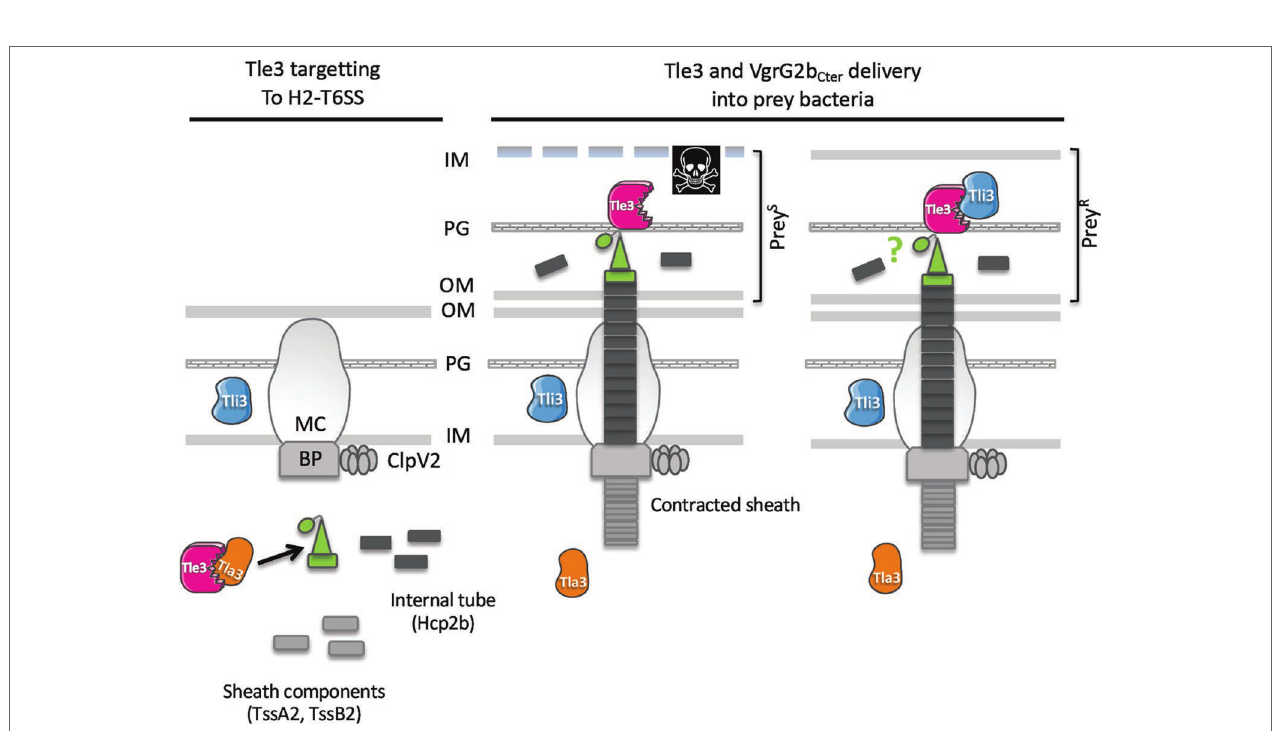
FIGURE 8 | Working model: Tle3 targeting to the H2-T6SS machinery (left panel) Tle3 (in pink) is taken in charge in the cytoplasm by Tla3 (in orange) that binds VgrG2b (green). Upon Hcp2b (in dark grey) assembly into the growing sheath (light grey), the VgrG2b loaded with the Tle3 is placed at the tip of the Hcp arrow. Tle3 and VgrG2b Cter delivery into bacteria (right panel). The sheath contraction in the cytoplasm propels the Hcp arrow towards the target bacterium. Tle3 associated with this expelled structure is thus translocated into target cells, as well as VgrG2b Cter (green circle). The prey is killed (Prey S ) except if it has the Tli3 immunity (in blue) in the periplasm (Prey R ). The mechanism of resistance to VgrG2b Cter is still unknown. OM, outer membrane; PG, peptidoglycan; IM, inner membrane; BP, base plate; MC, membrane complex. Prey S , sensitive prey; Prey R , resistant